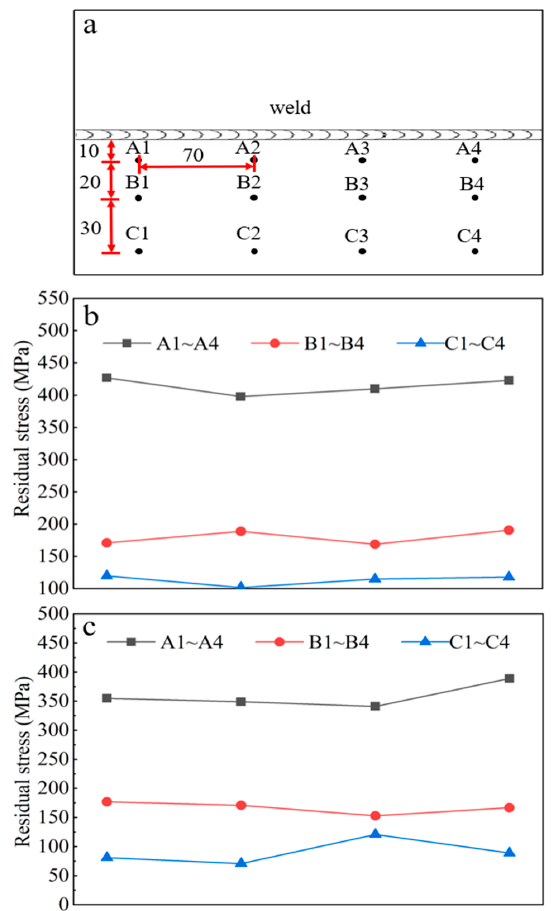
Figure 11. Diagram of residual stress. ( a ) strain gauge distribution, ( b ) one-time welding, ( c ) preheating, welding, and post-heating.